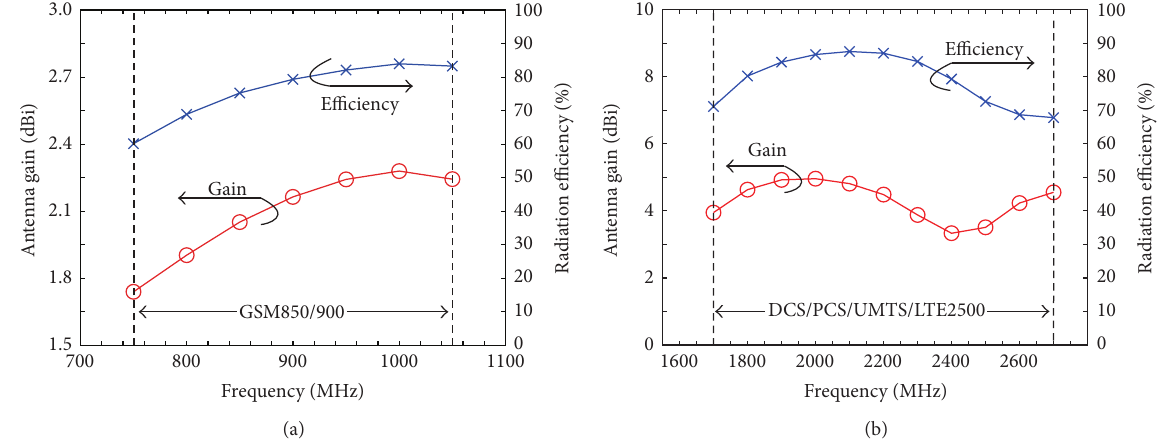
Figure 11: Measured antenna gain of the proposed antenna at (a) lower band and (b) upper